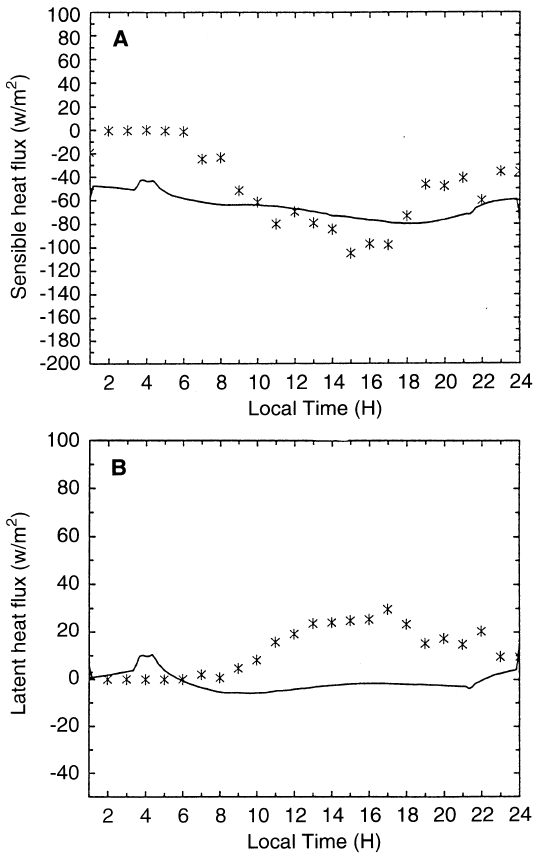
Fig. 12A,B. As in Fig. 11 but for